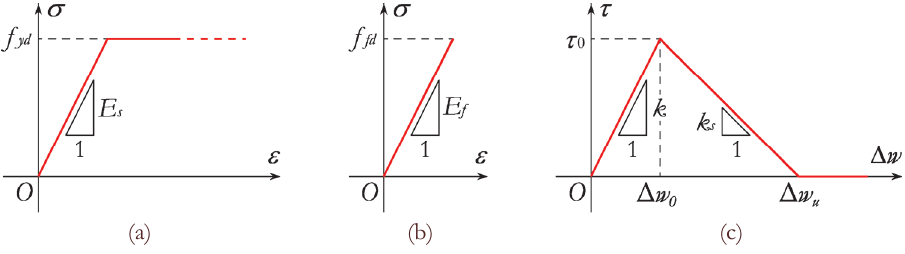
Figure 4: Constitutive laws: (a) steel, (b) FRP, (c)